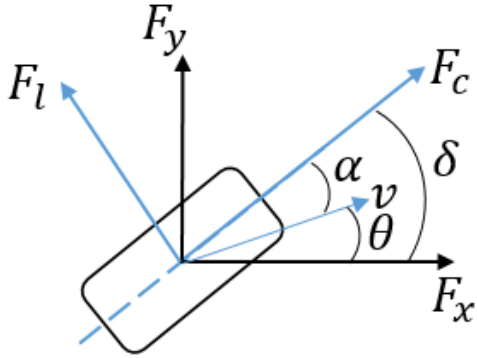
Figure 3. Tire force of a single wheel.